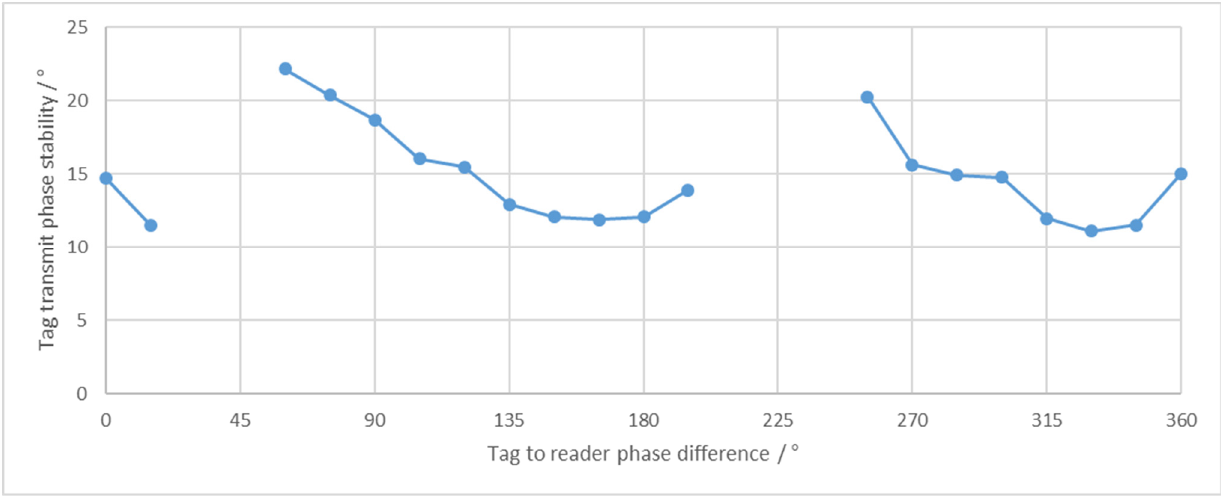
Figure 2. Phase stability of a system operating according to the principles presented in [19] was measured over a full range of tag to reader phase settings. At the set phases where no measurement results are shown, the system was not stable.